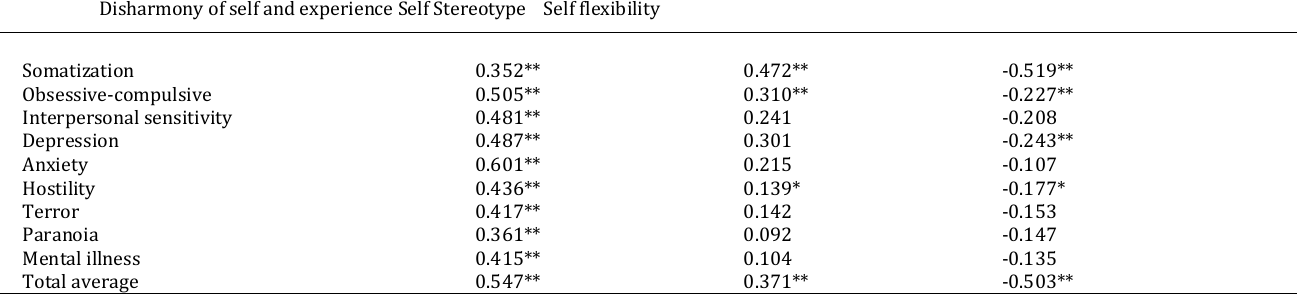
Table 2: Person Correlation Analysis of Self Consistency and Congruence and Mental Health